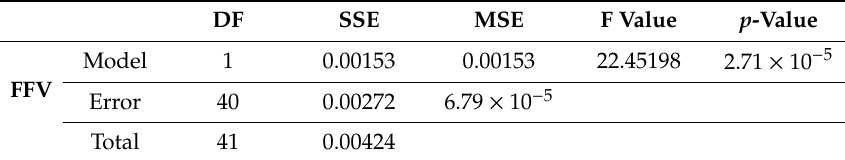
Table 3. The ANOVA table for FFV(T) model indicating that non-zero slope value hypothesis cannot